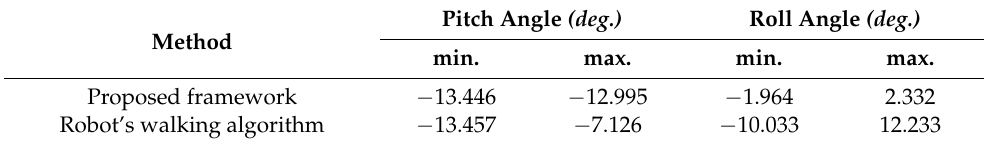
Table 9. The ranges of orientation angles for two methods.